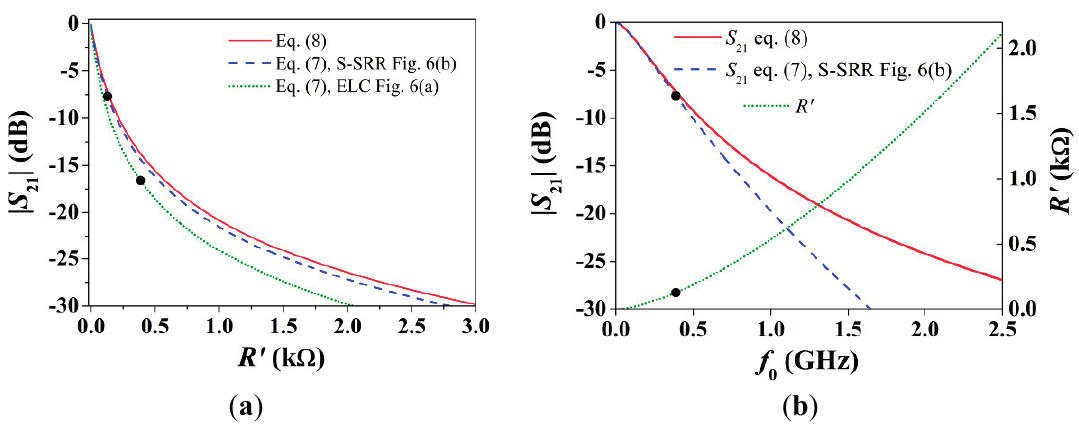
Figure 8. ( a ) Notch magnitude when sweeping R' ; ( b ) Notch magnitude and R' when sweeping f 0 . The circuit parameters are those indicated in Table 1, and Z 0 = 50 Ω . The specific operating points in Table 1 are also